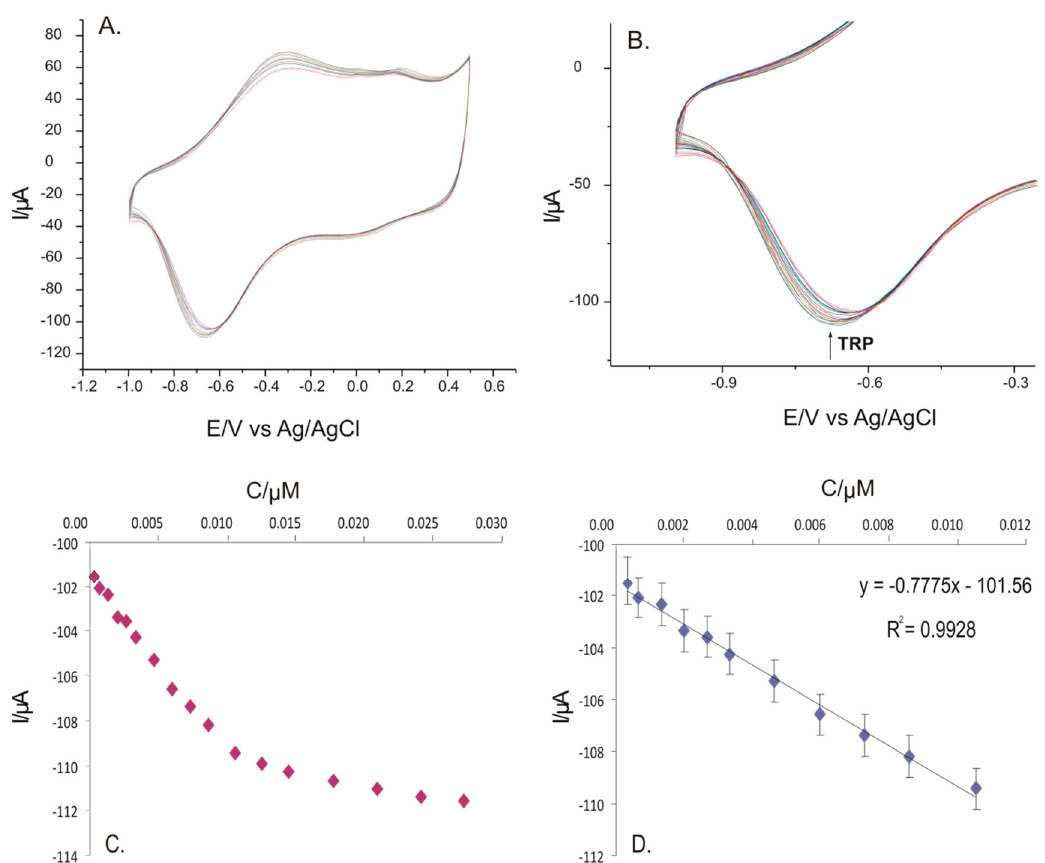
Figure 8. ( A ) Cyclic voltammograms of the PPy/FeCN sensor immersed in a double solution of 0.1 M KCl and 10 − 3 M L-TRP at different concentrations between 3.33 × 10 − 7 M and 2.72 × 10 − 5 M. ( B ) Zoomed in image on the catodic peak for which the calibration curve was developed. ( C ) Variation of the current of cathodic peak I with the TRP concentration. ( D ) Calibration curve in the range between 3.3 × 10 − 7 M and 1.06 × 10 − 5 M. Table 4. LOD and LOQ obtained with the PPy/FeCN sensor detecting L-TRP. Sensor